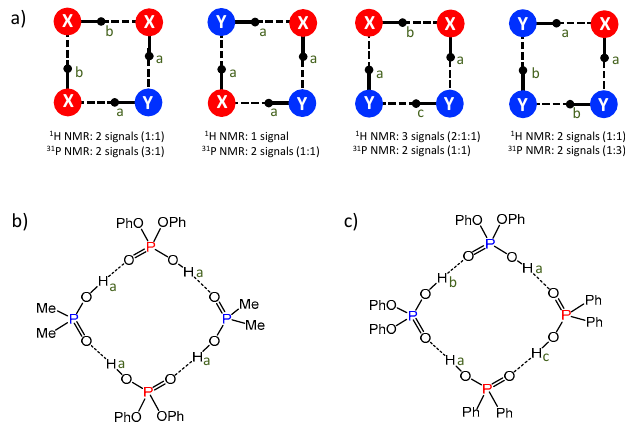
Figure 11. ( a ) The schematic representation of four possible structures of cyclic heterotetramers, formed by two different molecules (blue and red in this case); letters a, b and c indicate chemically non-equivalent bridging protons. ( b ) The proposed structure of heterotetramer of acids 1 and 4 (matches the spectral pattern seen in Figures 7 and 8). ( c ) The proposed structure of heterotetramer of acids 1 and 3 (matches the spectral pattern seen in Figures 5 and 6).